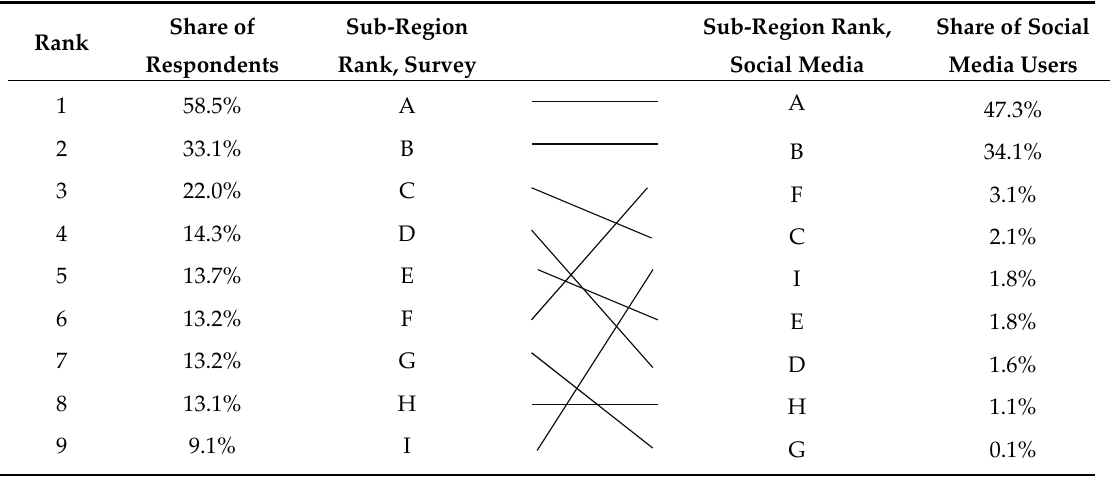
Table 2. Sub-region popularity based on visitor survey and geotagged Instagram posts. Location of sub-regions A-I are presented in Figure 1a. One respondent/user could be allocated to more than one sub-region. For the social media data, not all posts could be allocated to any of the